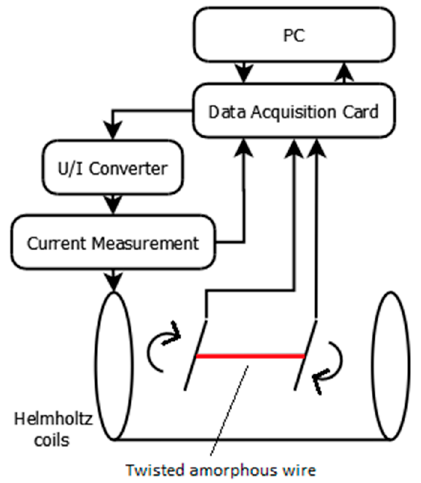
Figure 3. Simplified schematic block diagram of the measurement system.